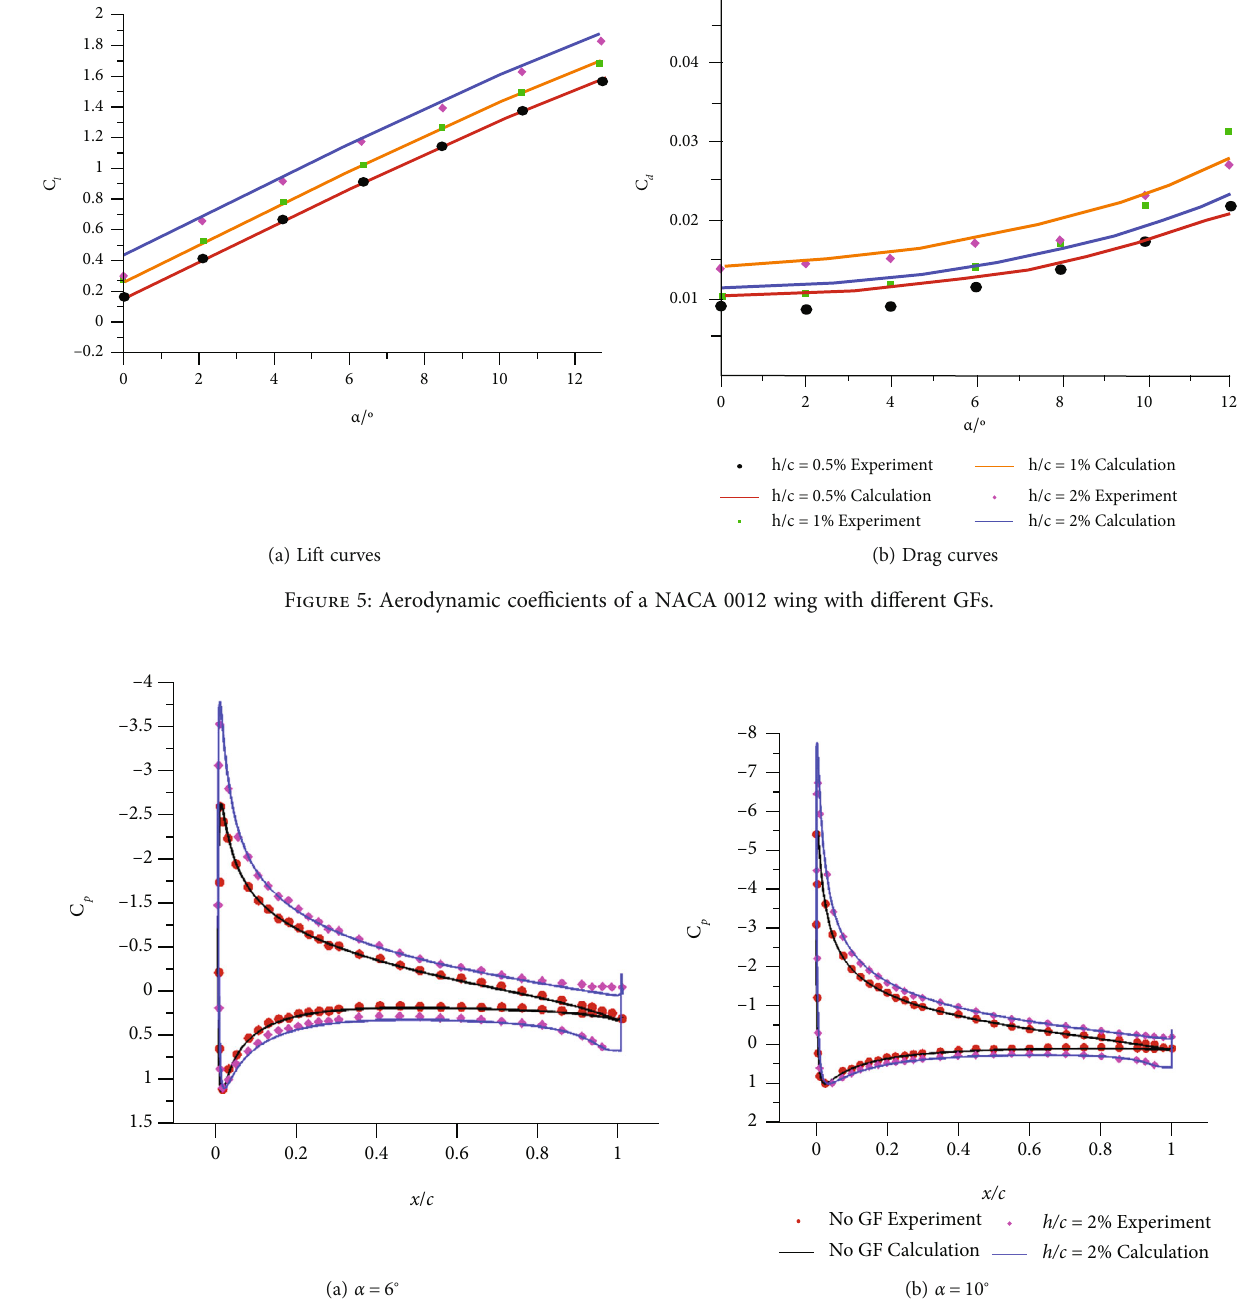
Figure 6: Calculated and experimental pressure distributions of a NACA 0012 wing without and with GF.